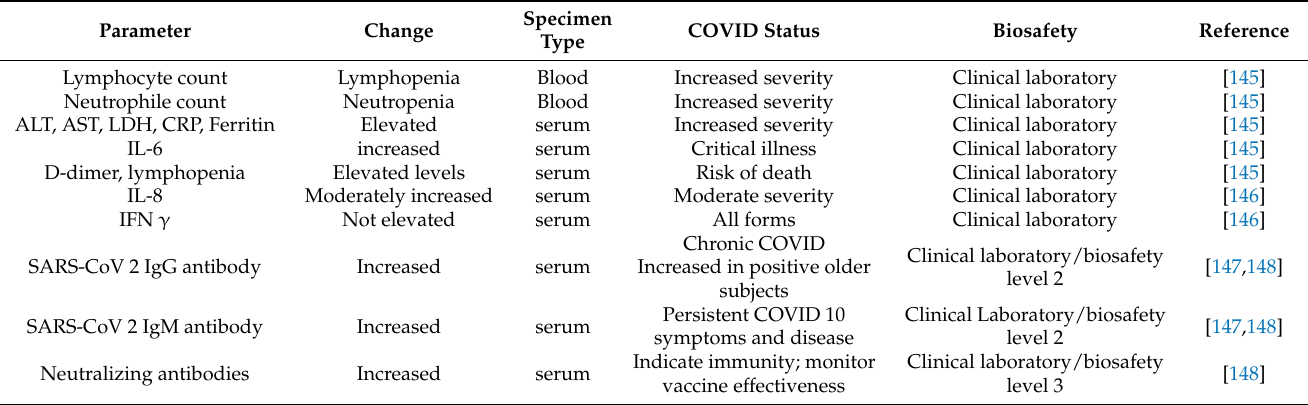
Table 4. Immunological markers used for the diagnosis and stratification of COVID-19